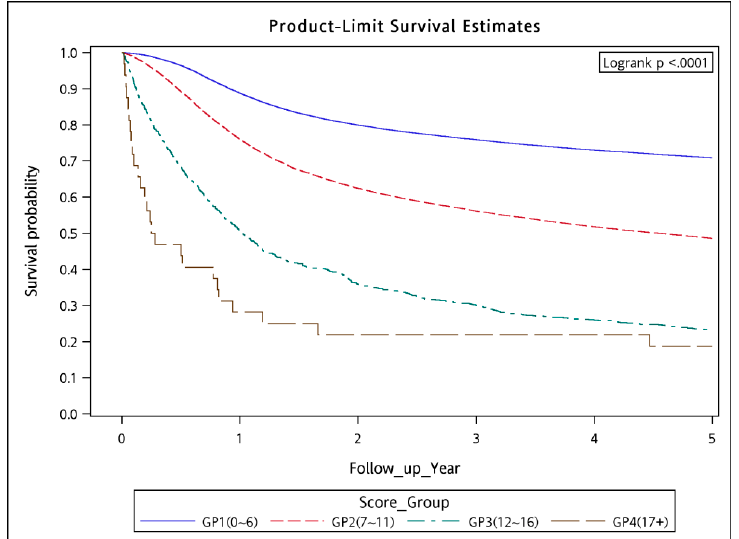
Figure 2. Kaplan–Meier curves for five years overall survival in patients with locoregionally advanced head and neck squamous cell carcinoma receiving curative surgery associated with the four risk groups. Note: p -value of Log Rank Test is <0.0001.